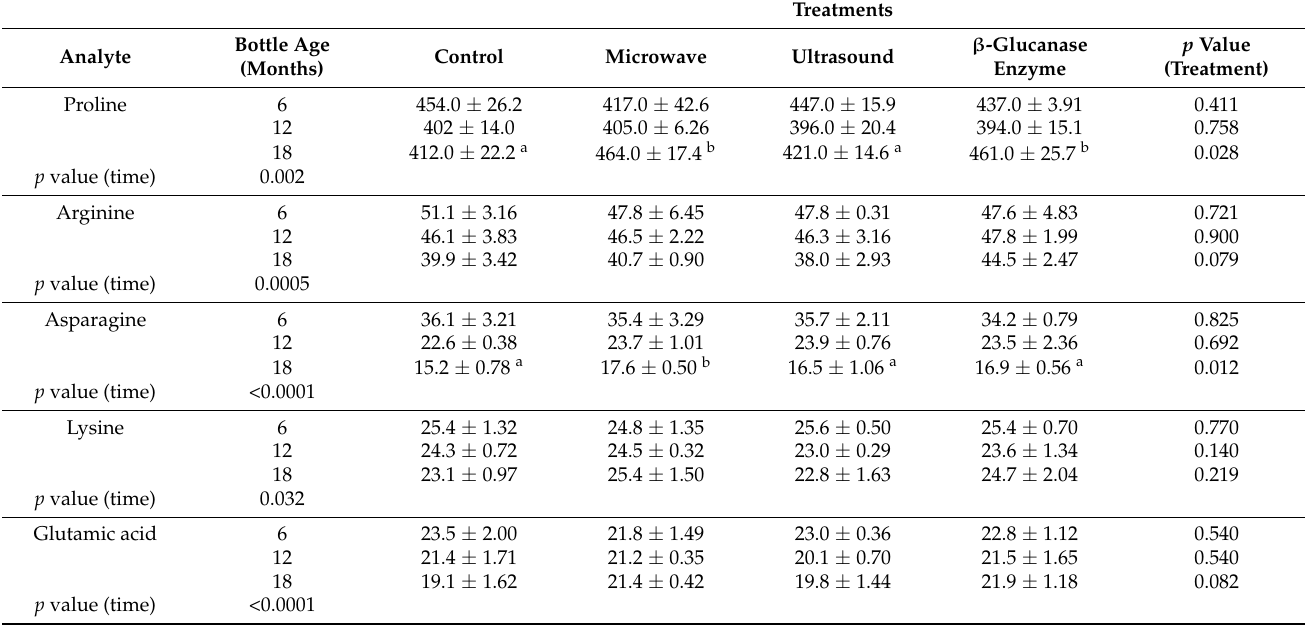
Table 2. Free amino acid concentrations 1 (mg L − 1 ) of sparkling wines after 6, 12 and 18 months ageing.